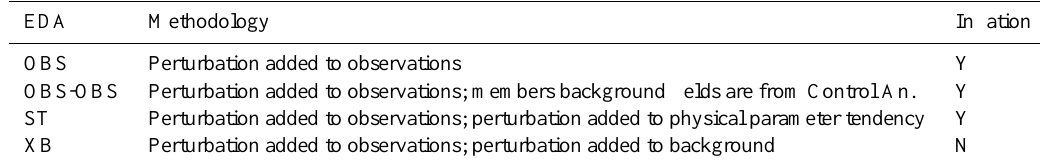
Table 1. Ensemble data assimilation configurations. EDA Methodology Inflation OBS Perturbation added to observations Y OBS-OBS Perturbation added to observations; members background fields are from Control An. Y